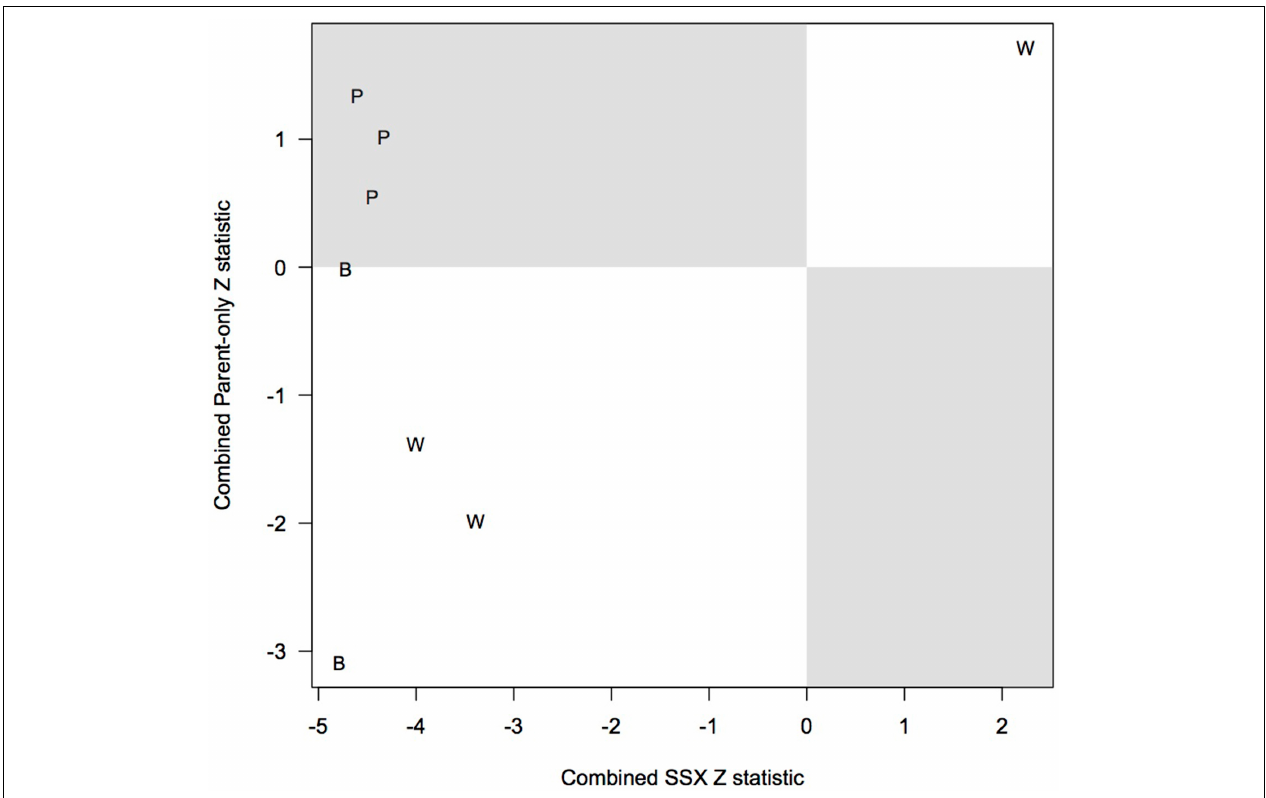
FIGURE 6 | Assessment of concordance through comparison of the parent-only Z scores and transmission (SSX) Z scores. The figure shows the top five single nucleotide polymorphism (SNP) hits from the PIX-LRT analysis and Patel et al. (2013) in Asian and Caucasian families with cleft lip with or without palate. We excluded SNPs in the Patel et al. (2013) analysis that raised quality control concerns. The parent-only and